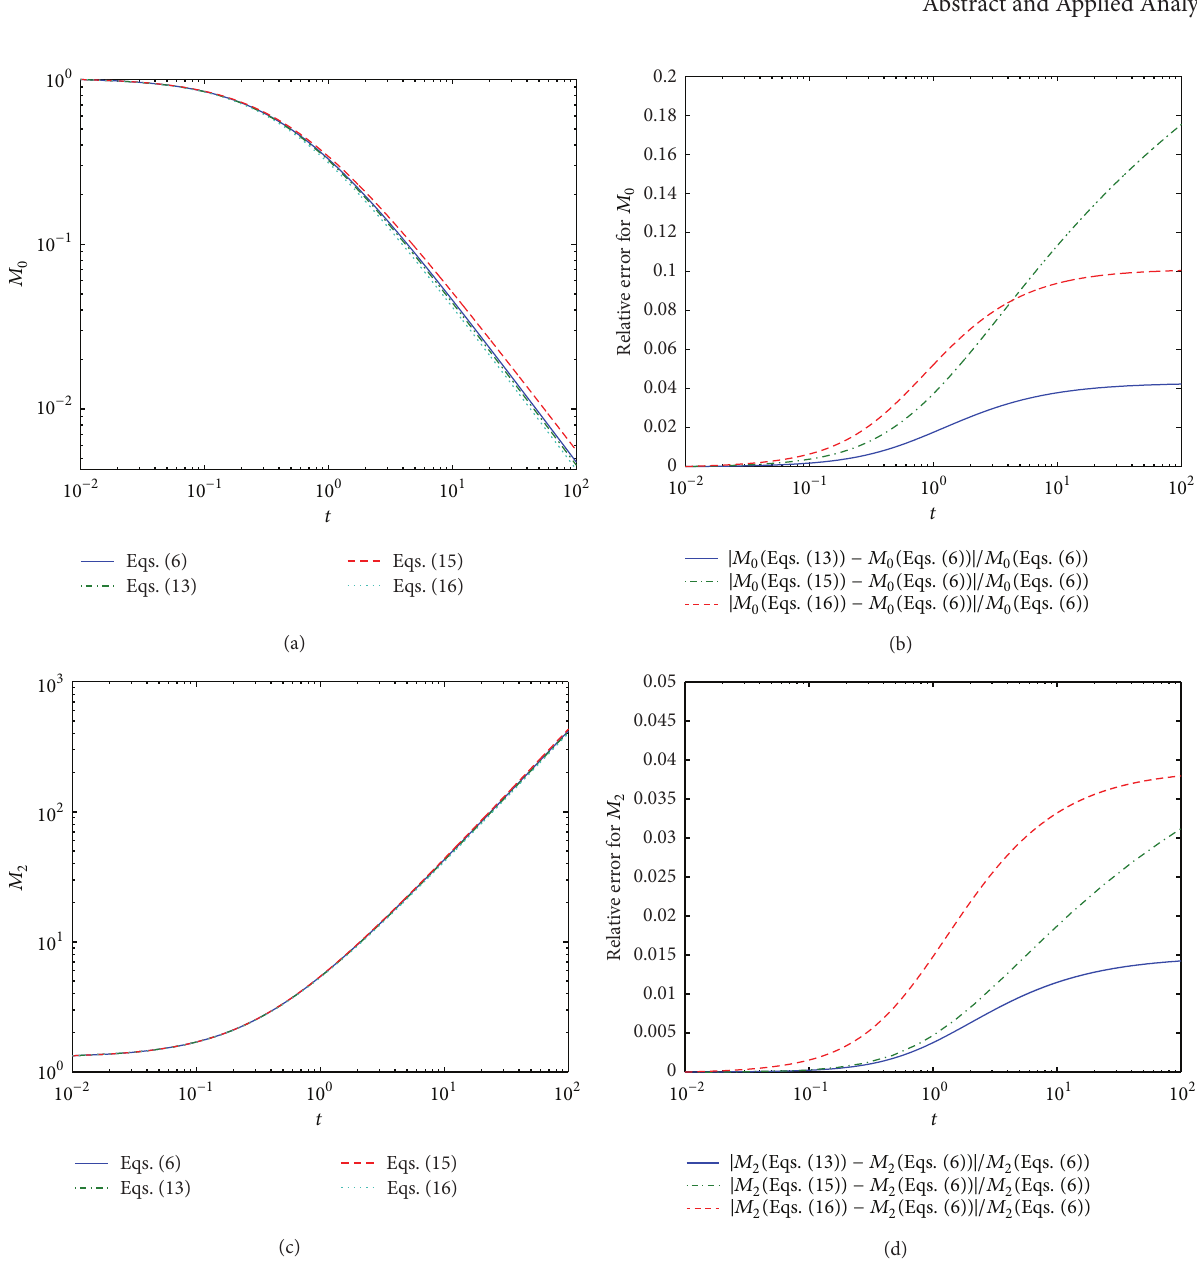
Figure 1: The comparison of numerical results among (6), (13), (15), and (16) with the initial condition 𝑀 00 = 1 , 𝑀 1 = 1 , and 𝑀 20 = 4/3 ; (a) the numerical results of 𝑀 0 ; (b) the relative errors for 𝑀 0 ; (c) the numerical results of 𝑀 2 ; (d) the relative errors for 𝑀 2